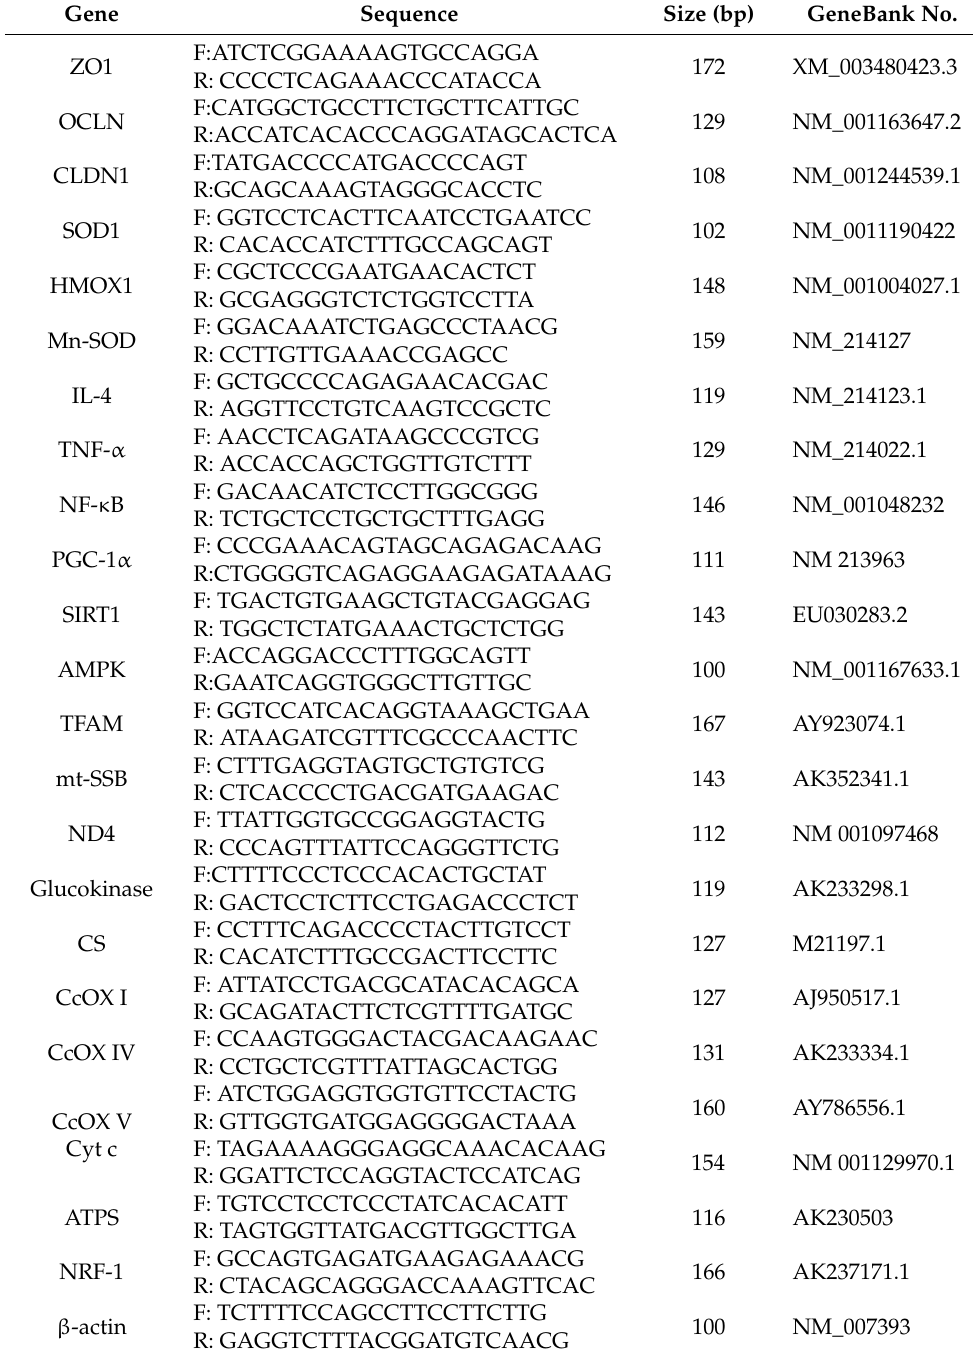
Table 2. Primers used for real-time